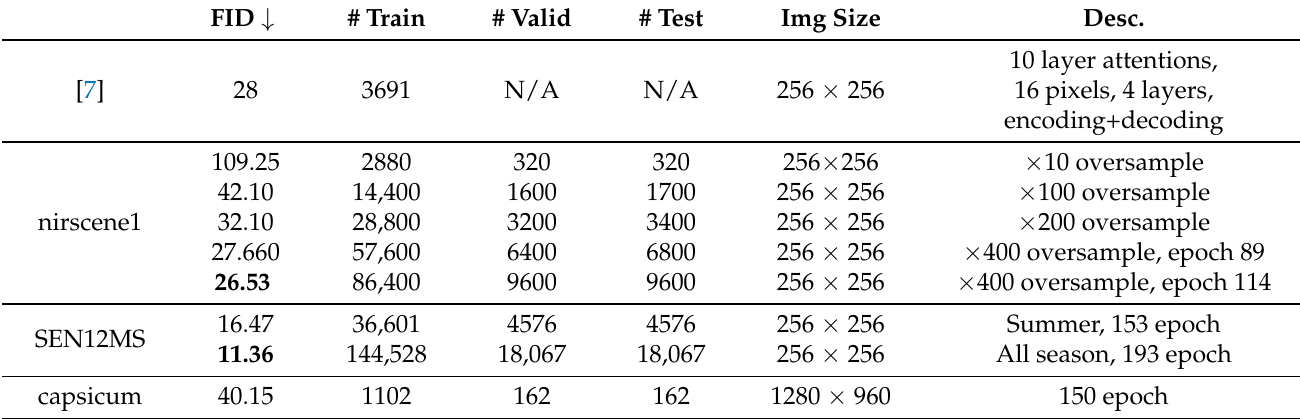
Table 5. Synthetic image generation quantitative